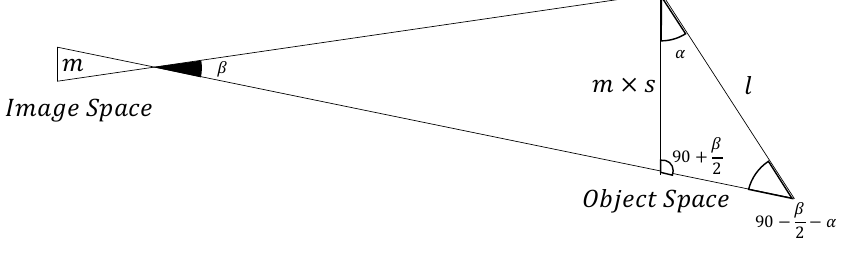
Figure 5. The angular equations for calibration.